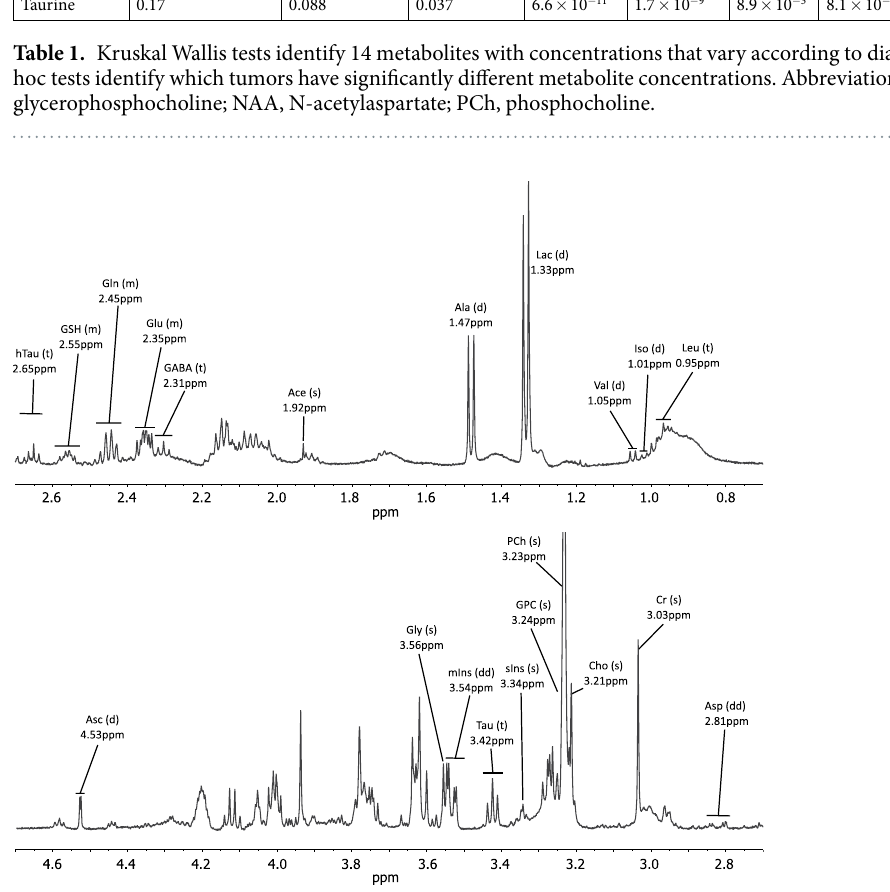
Figure 1. Example spectrum of a medulloblastoma acquired using HR-MAS. Metabolite assignments are shown along with their peak pattern. The resolution of the spectrum allows the accurate assignment and quantitation of a range of metabolites. Abbreviations: s - singlet, d – doublet, dd – doublet of doublets, t – triplet, m – multiplet, Ace – acetate, Ala – alanine, Asc – ascorbate, Asp – aspartate, Cho – Choline, Cr – Creatine, GABA - gamma-aminobutyric acid, Gln – glutamine, Glu – Glutamate, Gly – Glycine, GSH – glutathione, Htau – hypotaurine, Iso – Isoleucine, Leu – leucine, mIns - myo -inositol, sIns - scyllo -inositol, Tau – taurine, Val - valine.